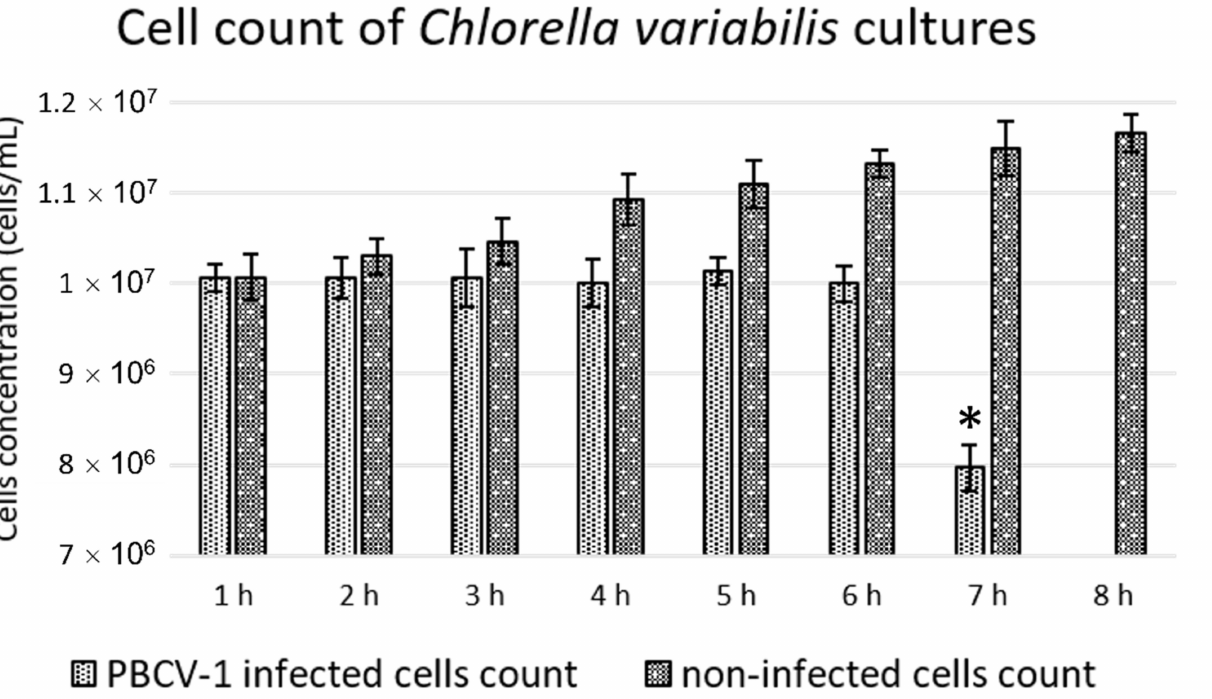
Figure 3. Cell count of PBCV-1-infected (lighter bar) and noninfected (darker bar) Chlorella variabilis cultures for the estimation of the culture crash time. The data represent the average of 3 biological replicates with calculated standard deviations. The asterisk indicates statistical significance compared to the previous timepoints with a p -value lower than 0.01.